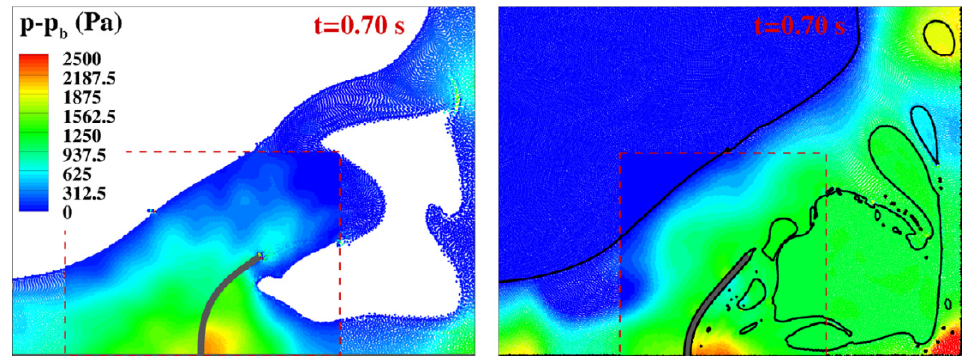
Figure 10. δ -SPH results showing the pressure field around the air cavity formed by the dam-break flow (black lines represent the interfaces of multiphase flows)